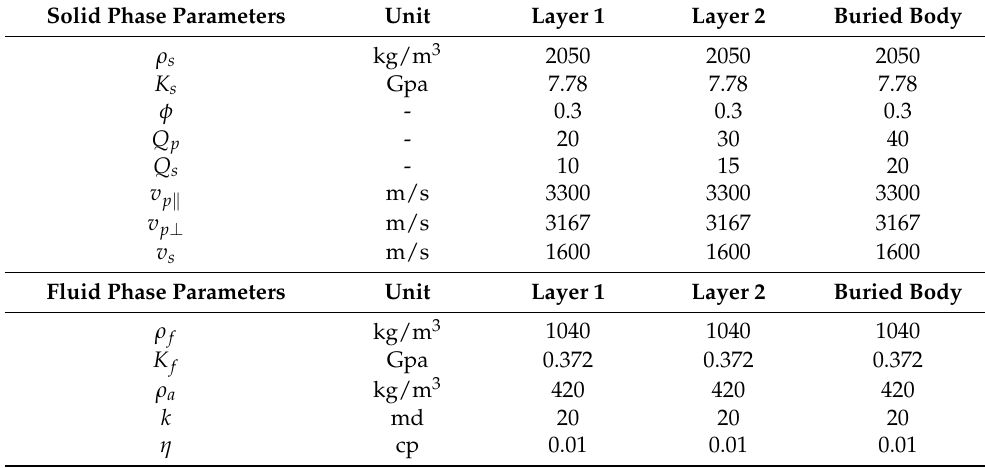
Table 3. Double-layer model with three different quality factor